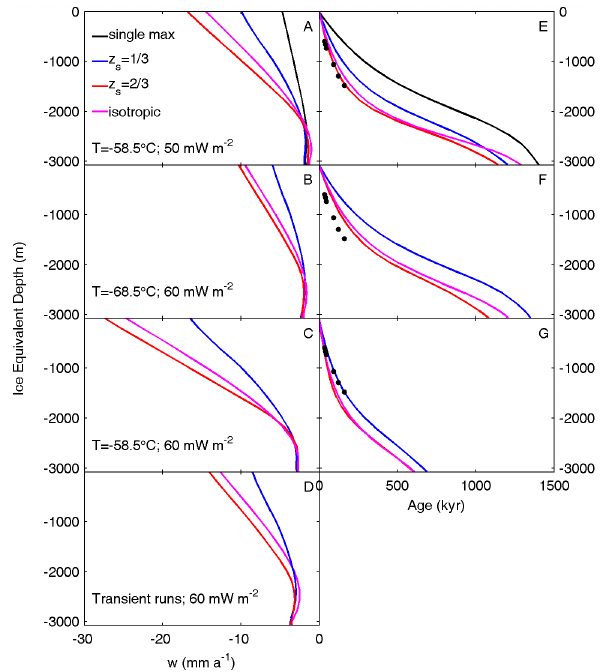
Figure 4. ( A–D ) Vertical velocity, w , as a function of depth from the surface to bedrock for different fabrics, surface temperature and geothermal heat flux at Kunlun station. (A–C) are steady-state sim- ulations using fabric as in the key of (A) . Surface temperatures and geothermal heat fluxes and surface temperatures are labelled on the panels. (D) is for the transient simulations with time-varying surface temperature (Table 1) from 130kyr BP. (E–G) Age–depth profile at Kunlun station corresponding to the simulations in the left column. The black points denote the age–depth data from dated radar inter- nal reflection horizons tracked from the Vostok ice core site, using a 46m firn correction subtracted from the radar depths to convert to the ice-equivalent model scale. No age calculation is possible for the short transient runs, but the expected ages may be judged by relation to the steady-state w simulations.